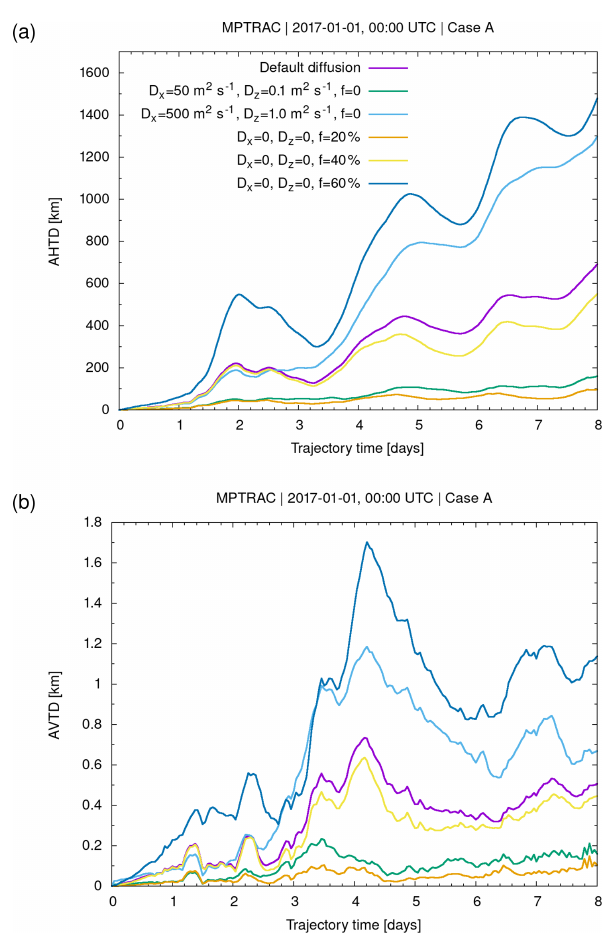
Figure 4. Absolute horizontal transport deviations (AHTDs, a ) and absolute vertical transport deviations (AVTDs, b ) between trajec- tory calculations with and without simulated diffusion and subgrid- scale winds. Statistics refer to case A presented in Fig. 2. The sim- ulations use different parameter choices of the diffusivities D x and D z and the scaling factor f for the subgrid-scale variances (see plot key). Default parameters (purple curve) are D x = 50m 2 s − 1 in the troposphere, D z = 0 . 1m 2 s − 1 in the stratosphere, and f =